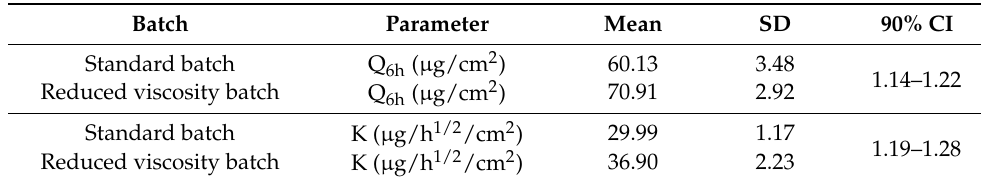
Table 5. The 90% confidence intervals (CIs) of release parameters (released amount of capsaicin at 6 h (Q 6h ) and release constant (K)) of a reference formulation versus a reduced viscosity formulation. SD: standard deviation.